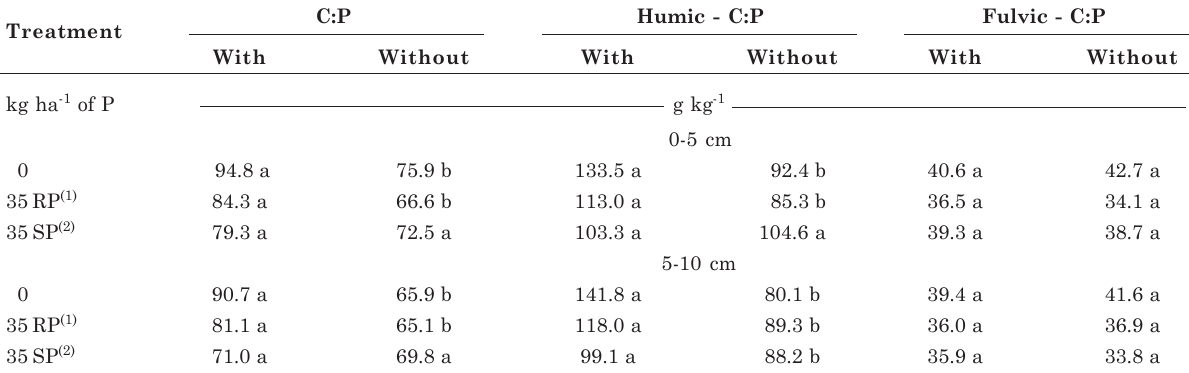
Table 5. Mean values of the carbon and phosphorus (C:P) ratio in the soil at 0-5 and 5-10 cm depths under broadcast application of phosphorus sources and Brachiaria ruziziensis (presence - with; absence - without)